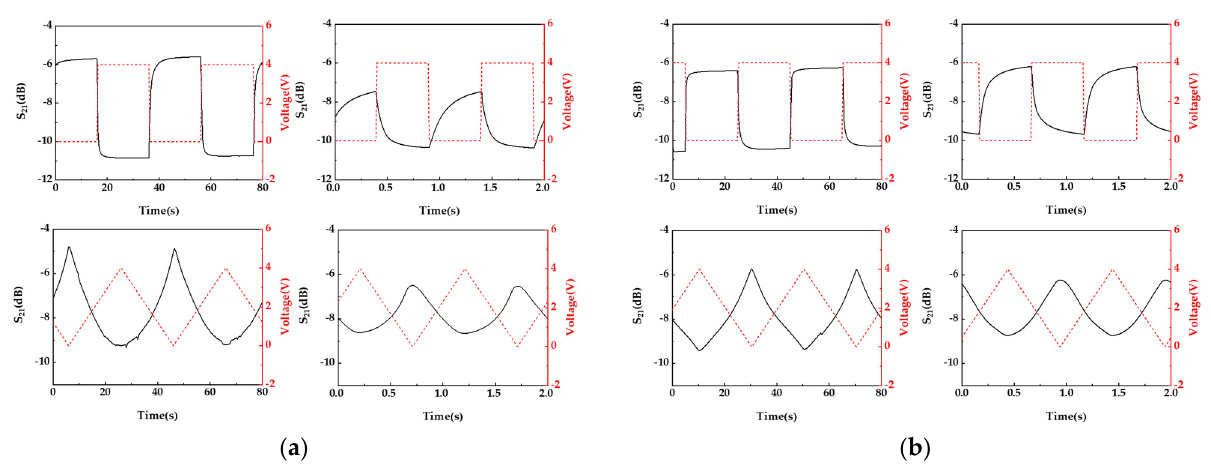
Figure 9. Transmission curves of ( a ) the MIM and ( b ) the BIB structure when applying rectangular and triangle waves with the frequency of 250 mHz and 1 Hz.